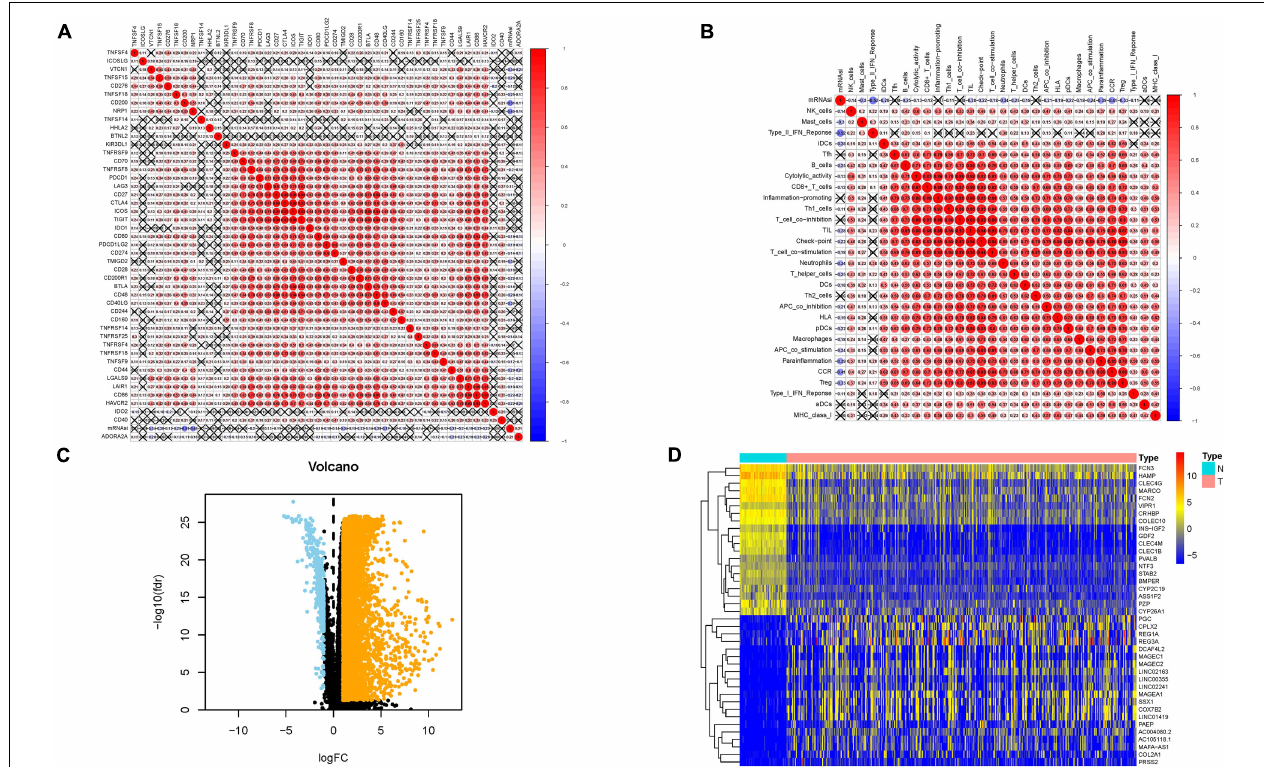
FIGURE 2 | Associations of the stemness index with the tumor immune microenvironment in HCC. (A) Broad co-expression correlation among mRNAsi and expression of 47 immune checkpoint blockade genes in HCC. “ × ” means p ≥ 0.05. (B) Broad co-expression correlation among mRNAsi and immune infiltration in HCC. “ × ” means p ≥ 0.05. (C) Volcano plot was delineated to visualize the differentially expressed genes (DEGs). Orange represents upregulated and blue represents downregulated. (D) Heatmap of top 40 DEGs was drawn to reveal different distribution of expression state, where the colors of red to blue represent alterations from high expression to low